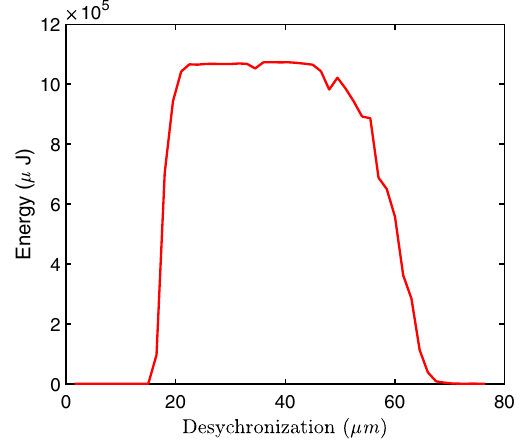
FIG. 11. The output laser energy as a function of electron beam shift distance in each